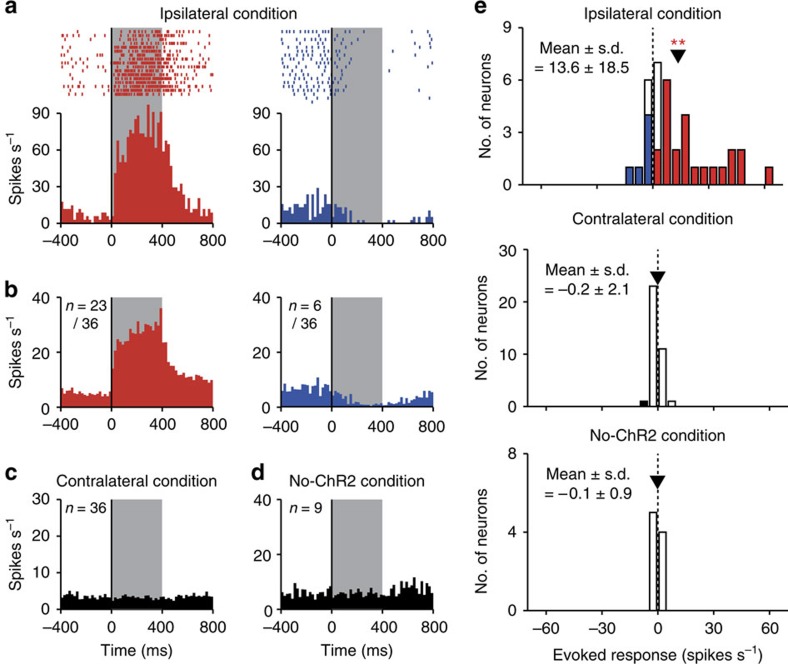
Neuronal modulations by the optical stimulation in the fixation task.(a) Activity of two SC neuron examples that were excited (left) and suppressed (right) in the ipsilateral condition. Histograms (20 ms bins) and rasters are aligned at the onset of the optical stimulation. Grey areas indicate the period of laser light emission. (b) Averaged activities of the excited (n=23, left) and suppressed neurons (n=6, right) in the ipsilateral condition. (c,d) Averaged activities in the contralateral (n=36 (c)) and no-ChR2 conditions (n=9 (d)). (e) Distribution of the evoked-response magnitude of each SC neuron in the ipsilateral (n=36, top), contralateral (n=36, middle) and no-ChR2 conditions (n=9, bottom). Filled bars indicate neurons showing a significant excitation or suppression (Wilcoxon signed-rank test, P<0.05). Arrowheads indicate the mean response magnitudes. Double asterisks indicate a significant deviation from 0 (Wilcoxon signed-rank test, P<0.01).